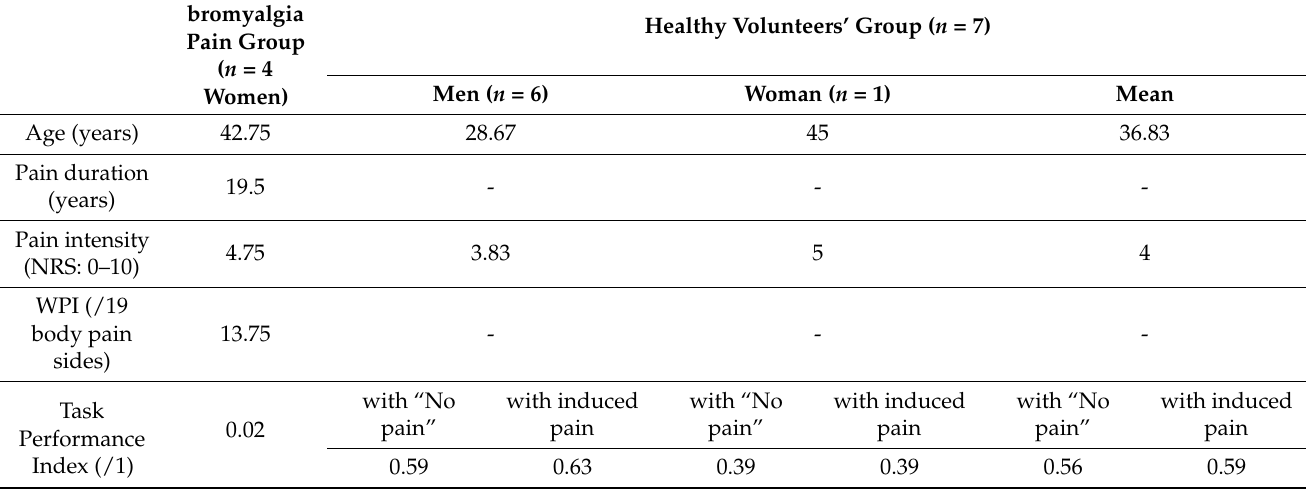
Table 1. Participants’